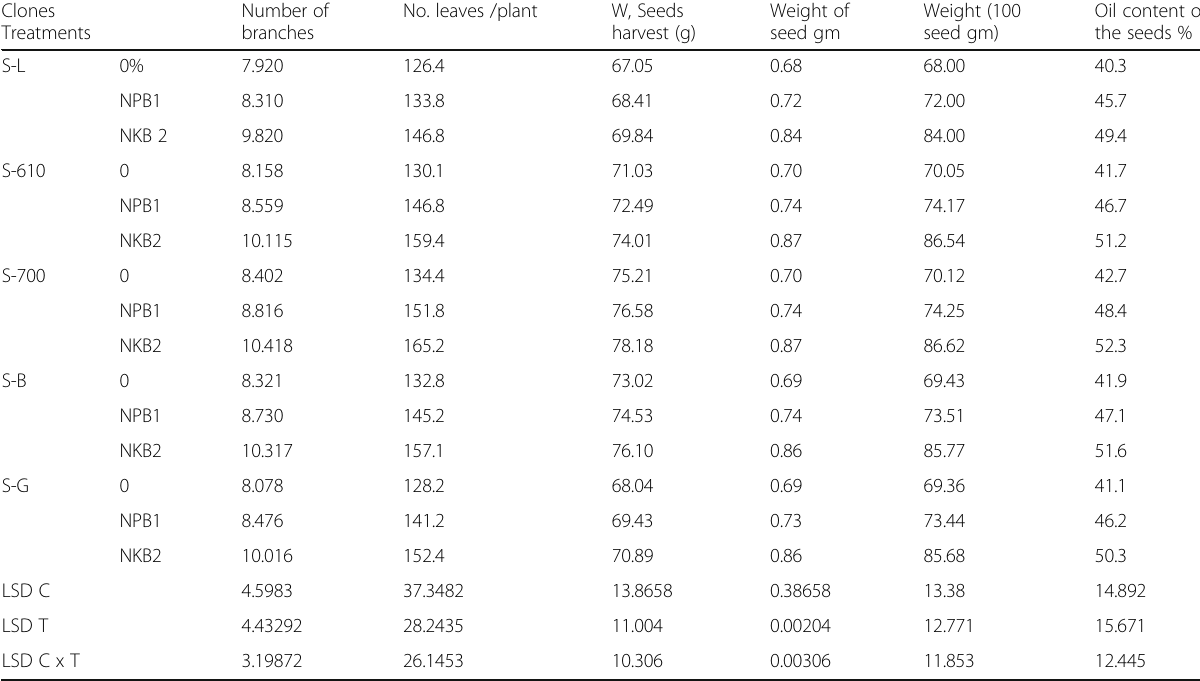
Table 4 Effect of NPB rates on yield of clones jojoba plants at 3 years Clones